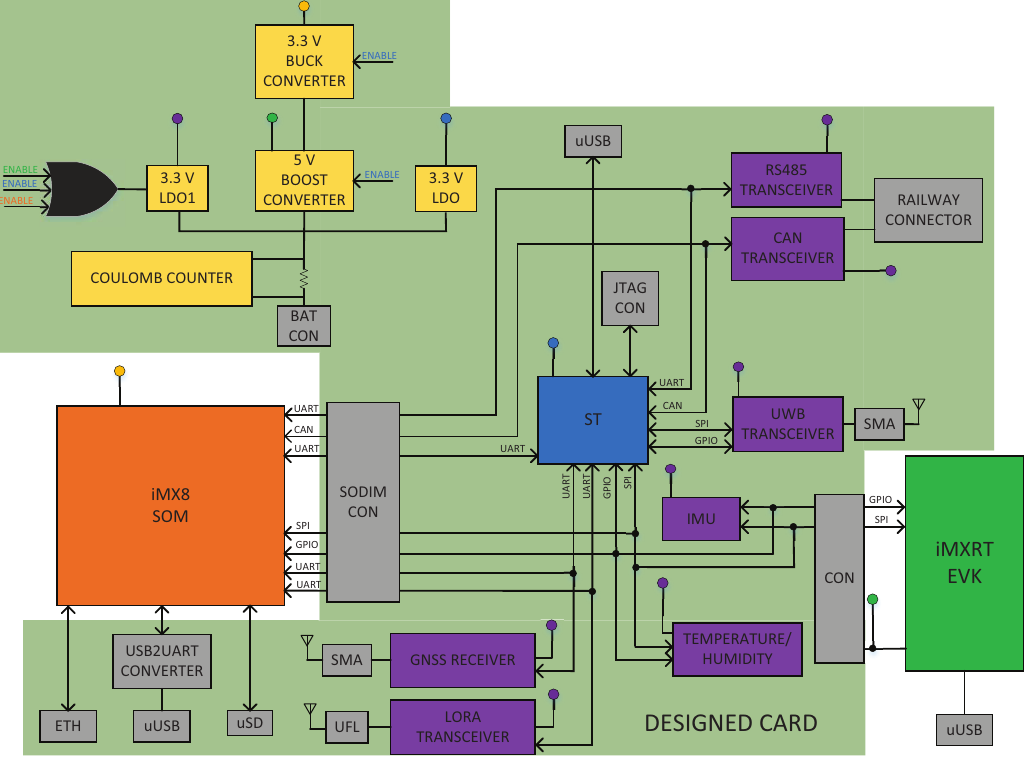
Figure 3. Block diagram of the proposed HW.